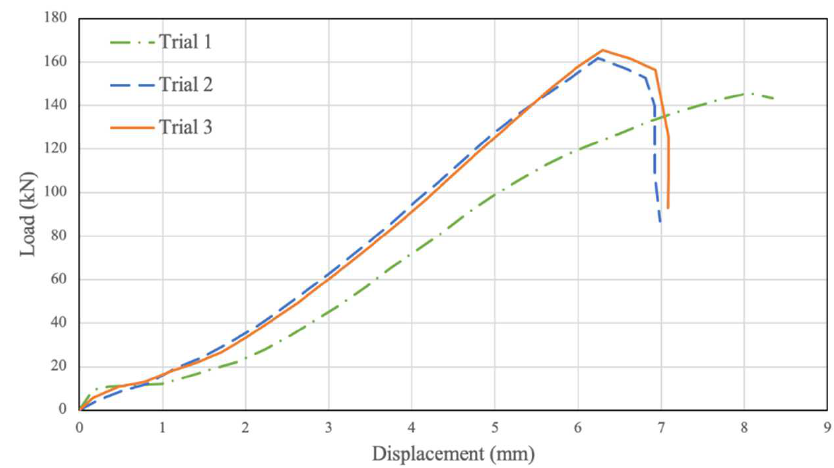
Figure 8. Confined 1.8 Mpa. Displacement vs. Load.